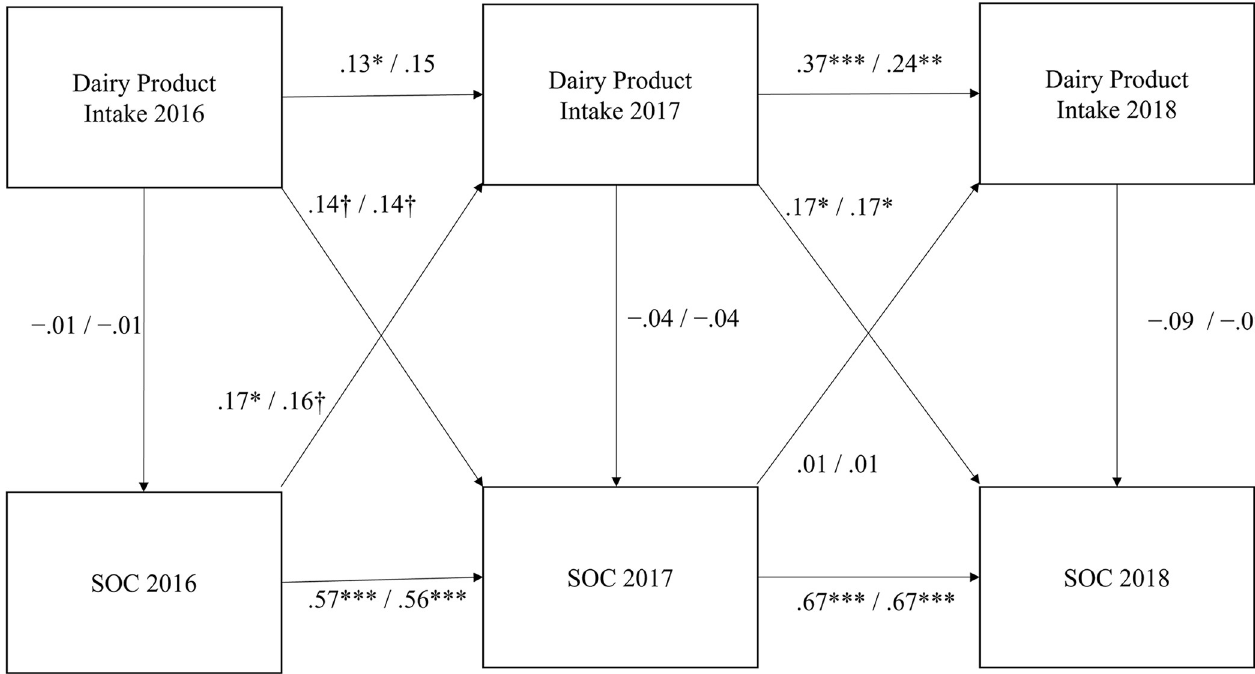
Fig 2. Structural model of the associations between dairy product intake and SOC. † p < .1; � p < .05; �� p < .01; and ��� p < .001. The coefficients shown are standardized path coefficients. Above: SB model/adjusted variables are sex and BMI. Below: SBF model/adjusted variables are sex, BMI, the consumption of green and yellow vegetables, fruits, and fish and shellfish in 2016, the consumption of grains, sugar and sweetener, beans, fruits, fish and shellfish, and meats in 2017, and the consumption of grains, fruits, fish and shellfish, fats and oils, and confections in 2018.